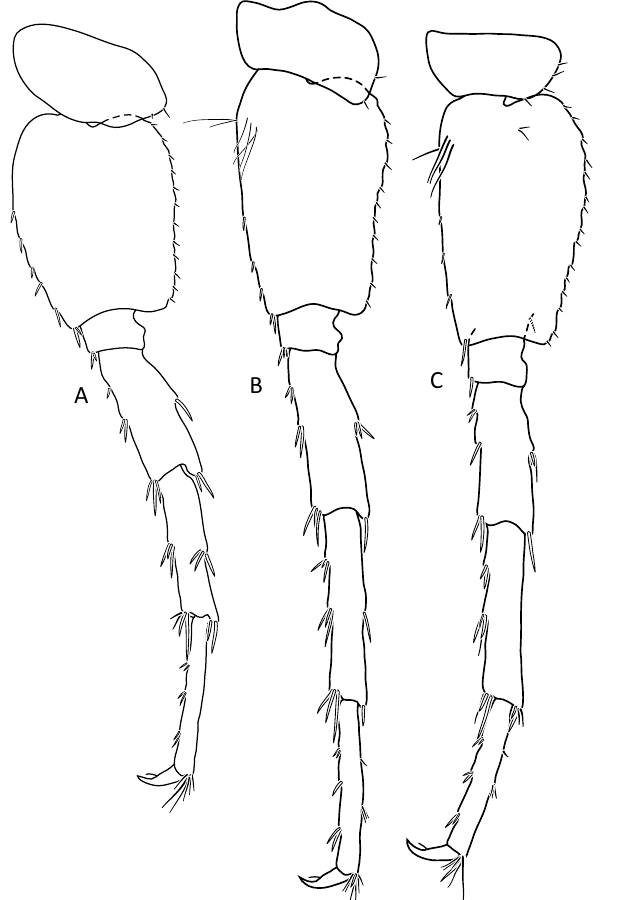
Figure 7. Gammarus stasiuki sp. nov., male—12 mm. ( a ) pereopod 5, ( b ) pereopod 6, ( c ) pereopod